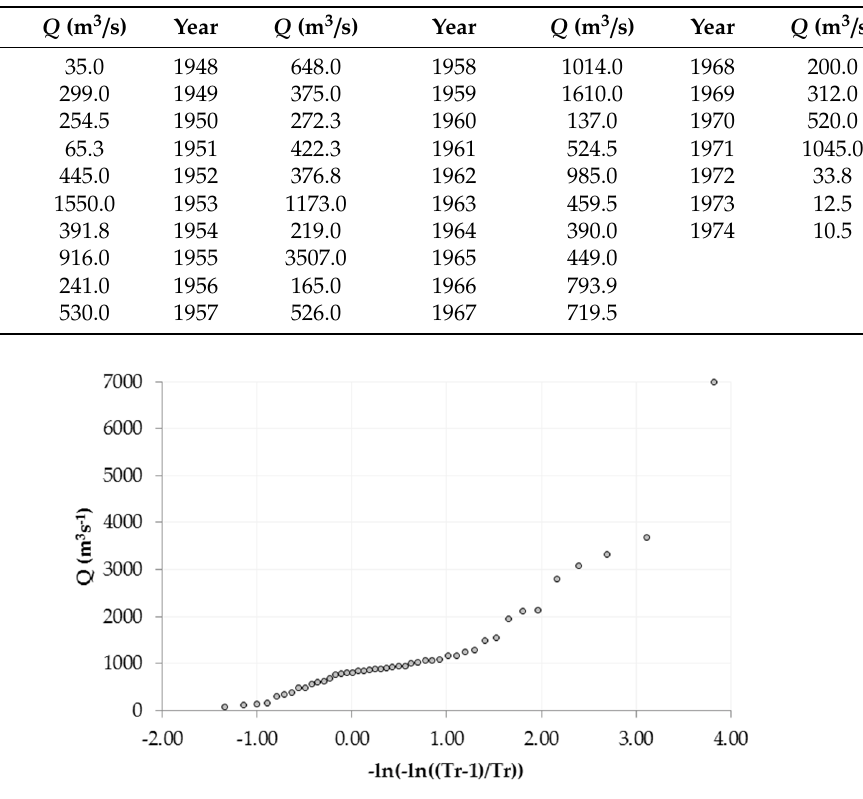
Table 2. Maximum annual flows recorded at hydrometric station 10031.